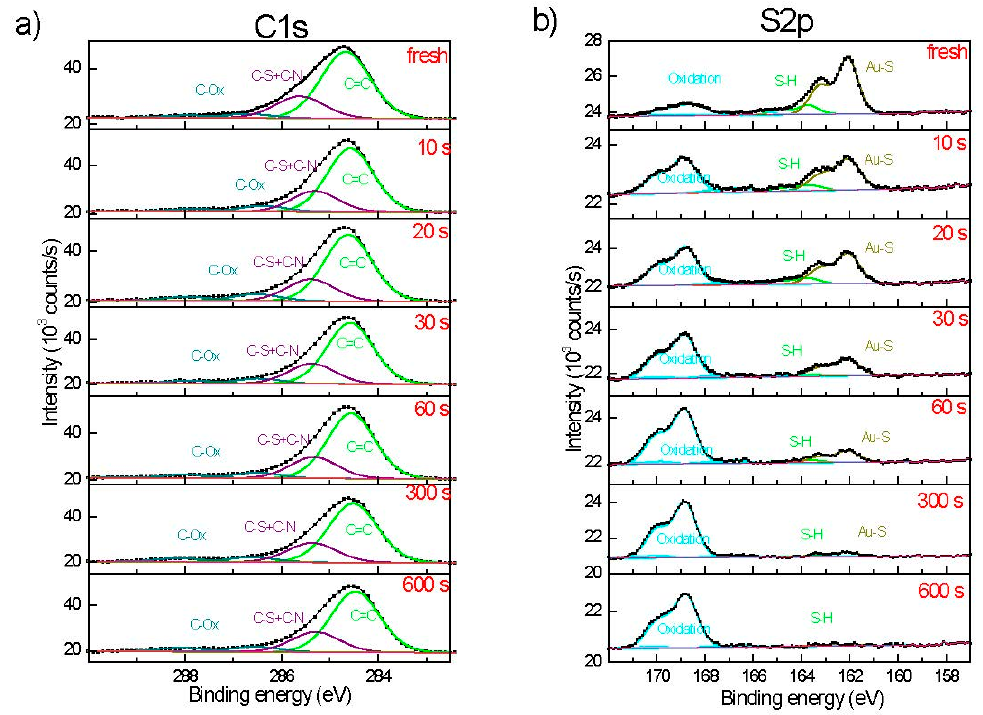
Figure 2. X-Ray Photoelectron spectra of freshly prepared and oxidized films. The treatment time in the ozone generator is indicated. ( a ) C1s spectra, ( b ) S2p spectra.